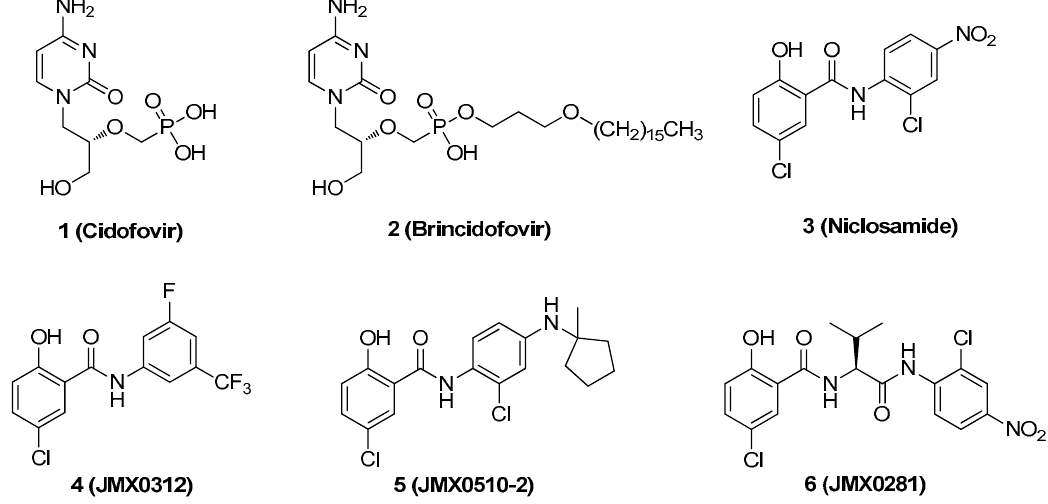
Figure 1. Representative human adenovirus (HAdV) inhibitors.